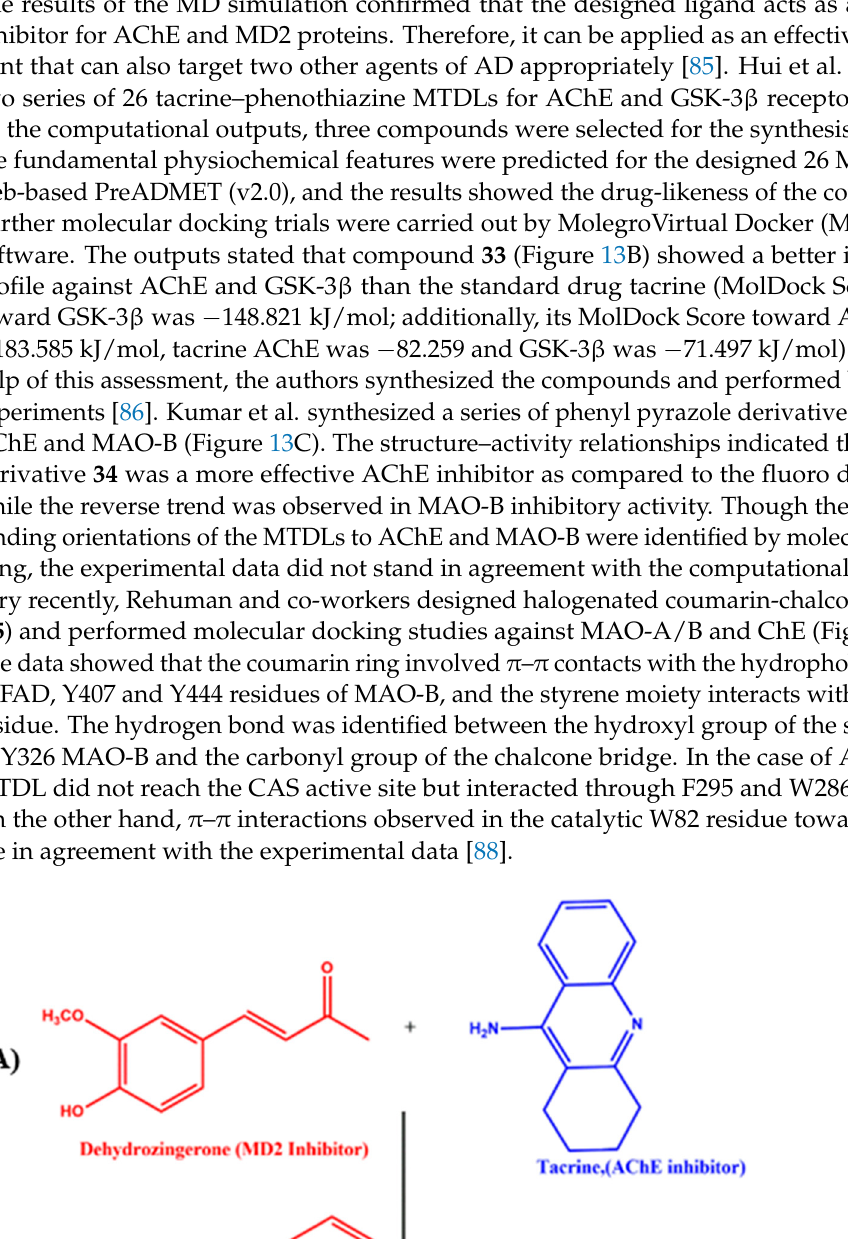
Figure 13. ( A − D ) MTDLs are designed using computational approaches.